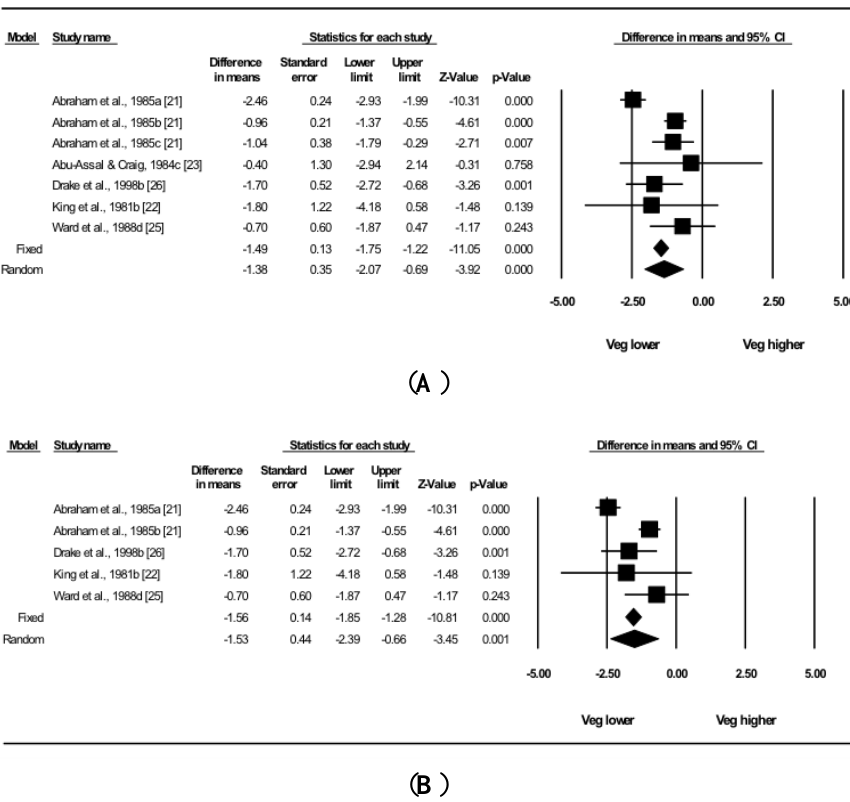
Figure 2. Analysis of dietary zinc intake (mg/day) compared to NV controls in ( A ) pregnant vegetarians; and ( B ) pregnant vegetarians with data from LoM excluded. Results are expressed as mean difference ± SE, with the standard error of difference calculated using the independence of vegetarian and control groups. a, lacto-vegetarian (V-L);